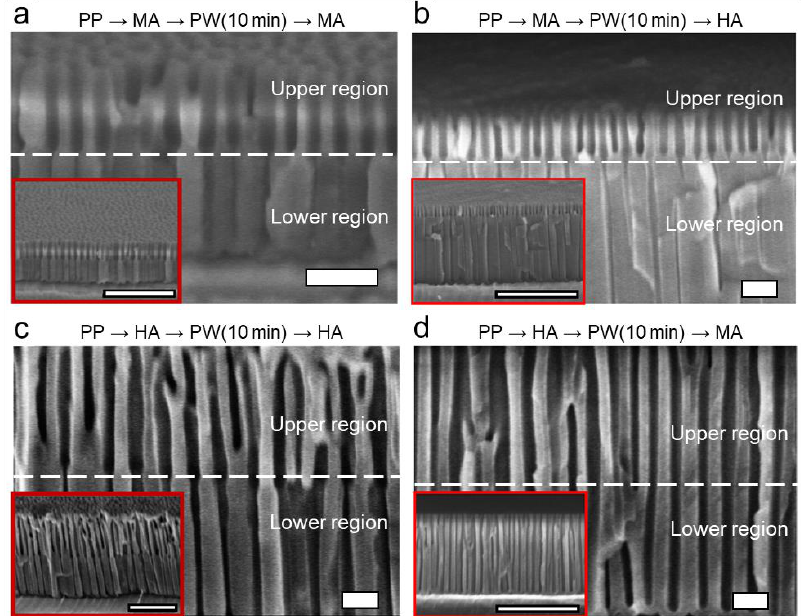
Figure 5. Cross-sectional SEM images of the nanoporous alumina layer formed on the pre-patterned (PP, via MA) aluminum substrate, as a result of the voltage-modulated stepwise anodizing process with the intermediate pore-widening (PW) step for 10 min in between. ( a ) PP → MA → PW → MA. ( b ) PP → MA → PW → HA. ( c ) PP → HA → PW → HA. ( d ) PP → HA → PW → MA. The conditions of MA and HA were 40 V for 30 min and 100 V for 0.5 min, respectively. The scale bar in each image represents 200 nm (1 μm in insets).